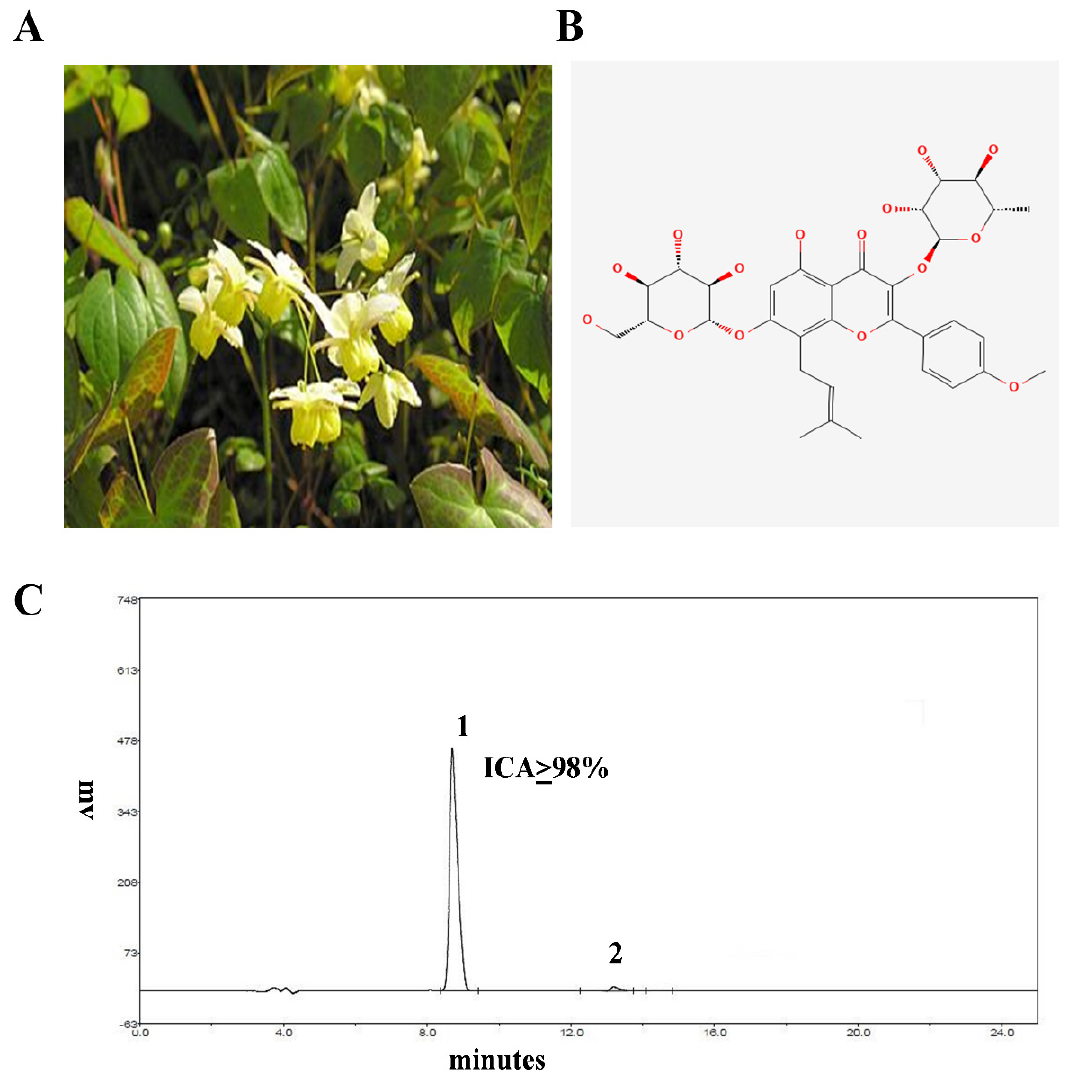
Figure 1. ( A ) Epimedium Brevicornum . ( B ) Structure of ICA. ( C ) HPLC chromatogram of ICA (the purity of ICA was more than or equal to 98%).